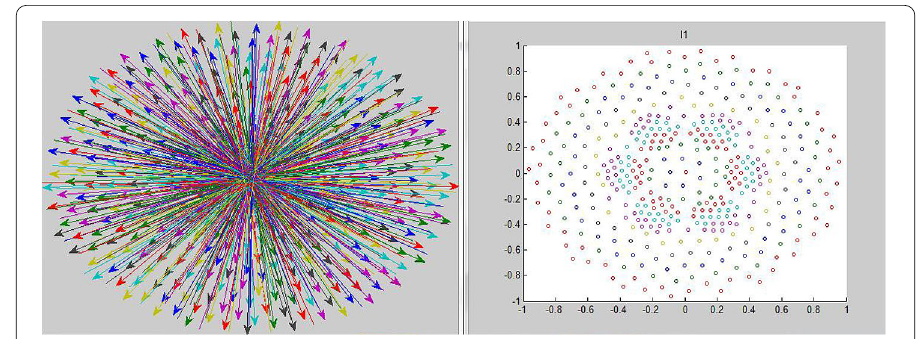
Figure 6 A discrete sampling of the intensity of the incoming beam (right) and the ray mapping (left)